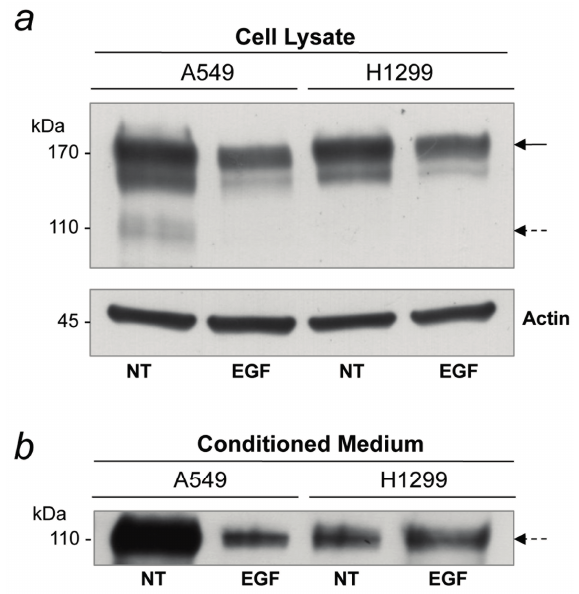
Figure 5. EGFR/sEGFR expression in tumor cells treated with EGF protein. A549 and H1299 cell lines were untreated or treated with EGF (100 ng/mL). ( a ) Western blot analysis of EGFR (170 kDa) and sEGFR (110 kDa) expression in A549 and H1299 cell lysates (50 µg) using the anti-EGFR ECD (Ab2_EGFR) antibody; ( b ) Western blot analysis of sEGFR (110 kDa) expression in A549 and H1299 conditioned medium (20 µg) using the anti-EGFR ECD (Ab2_EGFR) antibody. Solid arrows indicate the membrane p170 EGFR, and dashed arrows indicate the 110-kDa soluble